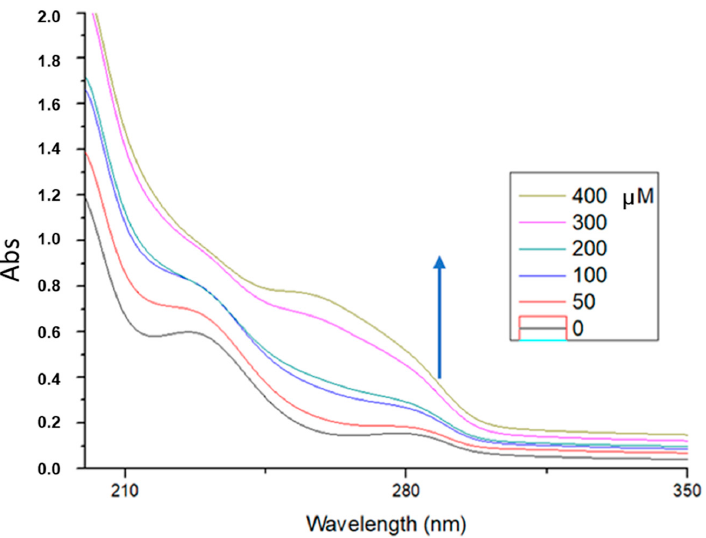
Figure 8. Absorption spectra of 6-shogaol in Tris-HCl buffer with increasing concentration of ctDNA (0–400 µ M). Arrow refers to hyperchromic (red shift) effect.